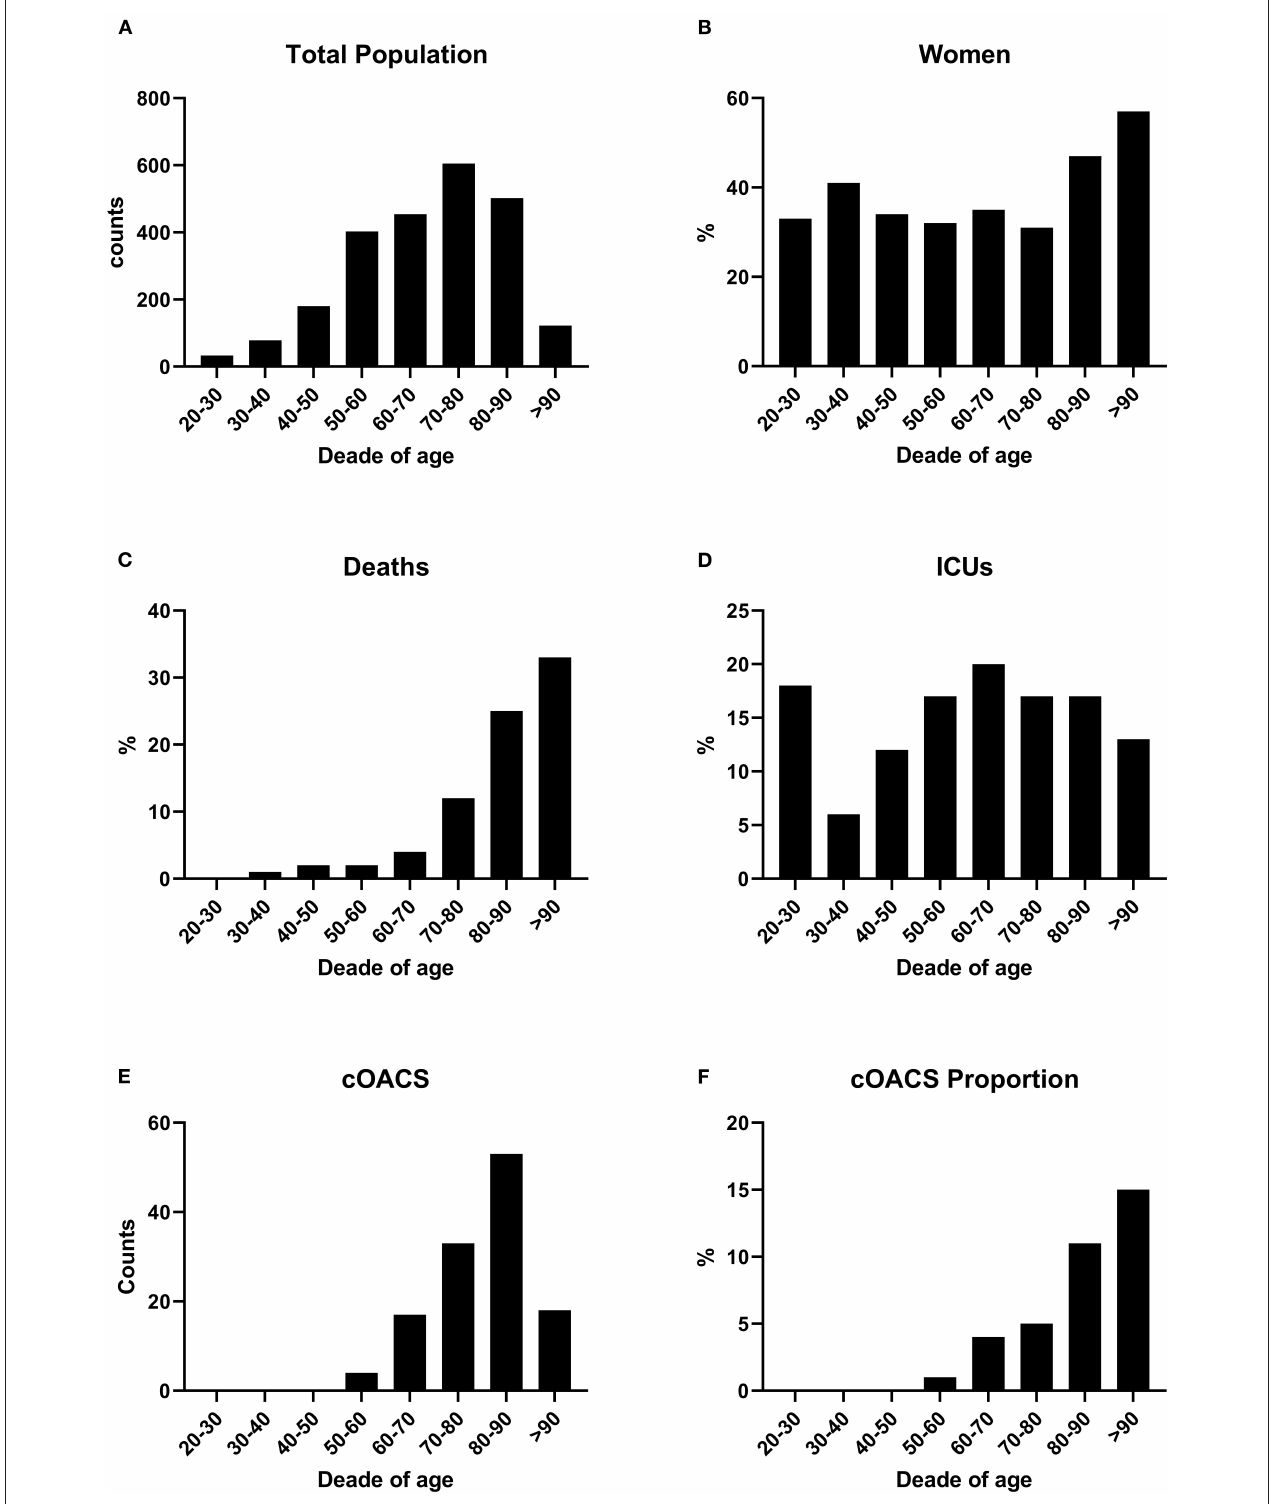
FIGURE 1 | (A) COVID-19 patients were grouped by age decades to show the impact of the disease according to age. Patient numbers increased by age decades. (B) Women were stably below 40% of total cases up to the age of 80 years. (C) Death rates increased with age. (D) ICU admissions were stable along all ages. (E) cOACs were administered increasingly with age. (F) The percentage of patients on cOACs increased with age.